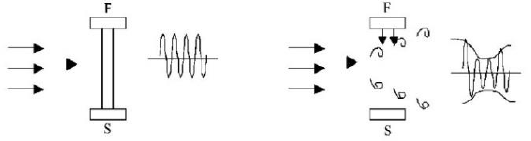
Fig. 2. Principle of vortex modulation